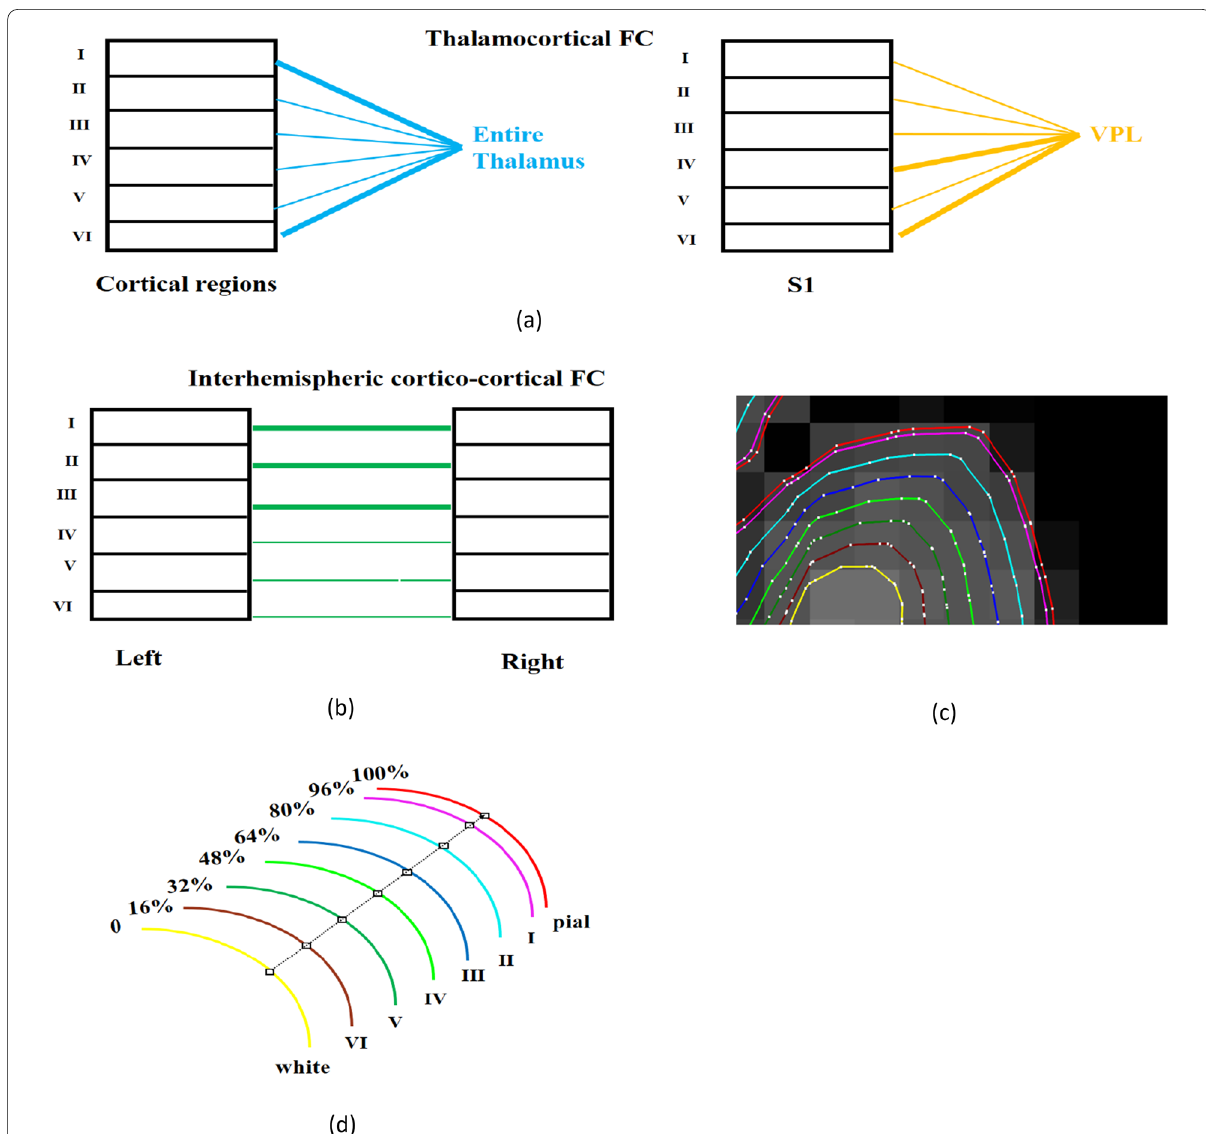
Fig. 1 Illustration of our functional hypotheses that were motivated by previous invasive anatomical tract tracing studies. The width of the lines represent the strength of the connections. a Thamalocortical hypotheses: we hypothesized that FC between the entire thalamus and cortical layers I and VI will be significantly stronger than between the thalamus and other layers (blue, left panel). Furthermore, FC between somatosensory thalamus (ventral posterolateral nucleus, VPL) and layers IV, VI of the primary somatosensory cortex (S1) will be stronger than with other layers (yellow, right panel). b Cortico-cortical hypothesis: inter-hemispheric cortico-cortical FC between homologous regions in superficial layers (layers I–III) will be stronger compared to that in deeper layers (layers V–VI). c 6 surfaces plus white matter and pial surface overlayed on anatomical MRI (white matter surface: yellow, layer VI surface: brown, layer V: green, layer IV: lime, layer III: blue, layer II:, cyan, layer I: purple, and pial surface: red; the white dots are the vertices on these surfaces). d Illustration of the relative distance of 6 intermediate surfaces to white matter